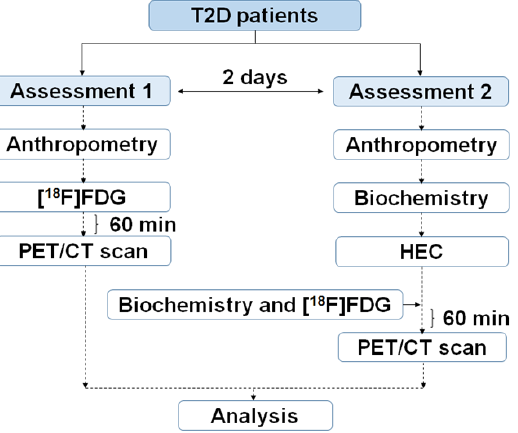
Figure 6. Outline of the clinical trial to obtain PET/CT, biochemical and anthropometrical data in T2D patients. T2D